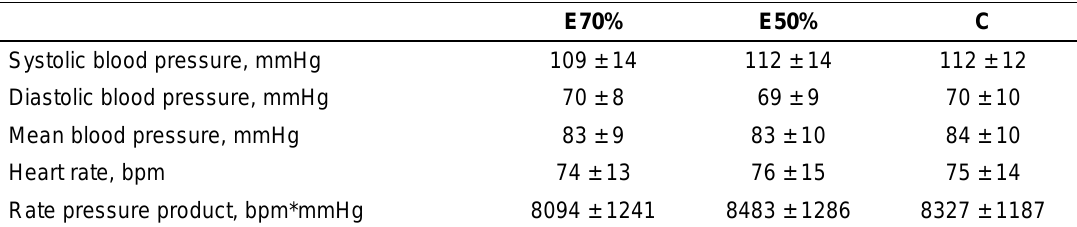
Table 3. Subjects pre-exercise